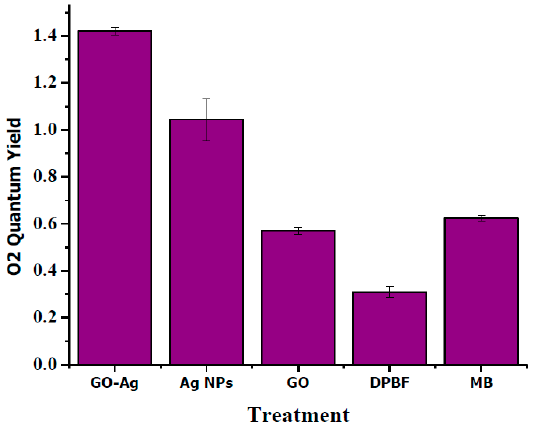
Figure 10. Quantum yield of singlet oxygen of GO-Ag, silver nanoparticles (Ag NPs), GO in comparison to MB.